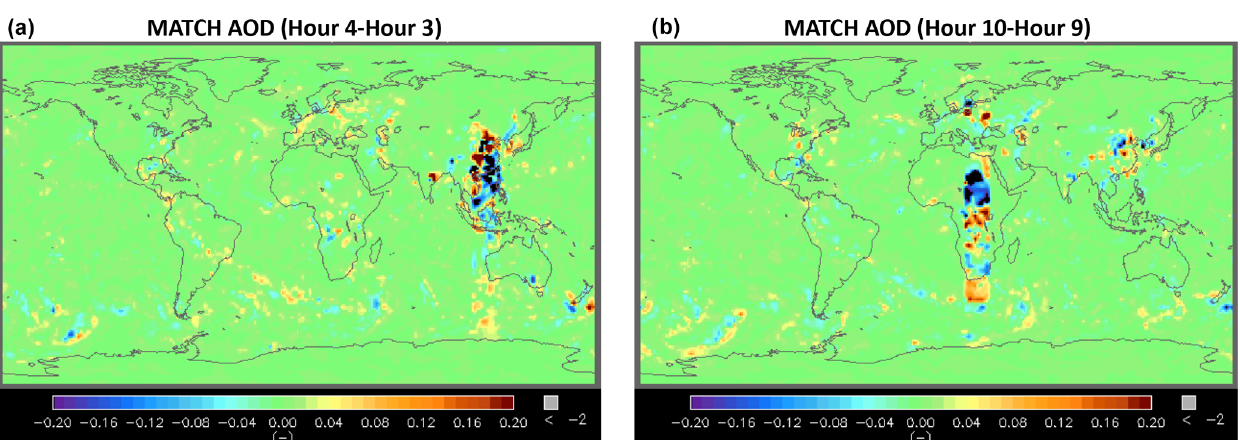
Figure 2. The difference in MATCH AOD due to the assimilation of MODIS AOD. Panel (a) shows 04:00UT minus 03:00UT on 1 Febru- ary 2020, and panel (b) shows 10:00UT minus 09:00UT on 1 February 2020. AOD is adjusted at the local solar noon within the 15 ◦ longitudinal band by the MODIS AOD assimilation. Wind-blown dust and sea salt differences are also apparent outside the 15 ◦ longitudinal